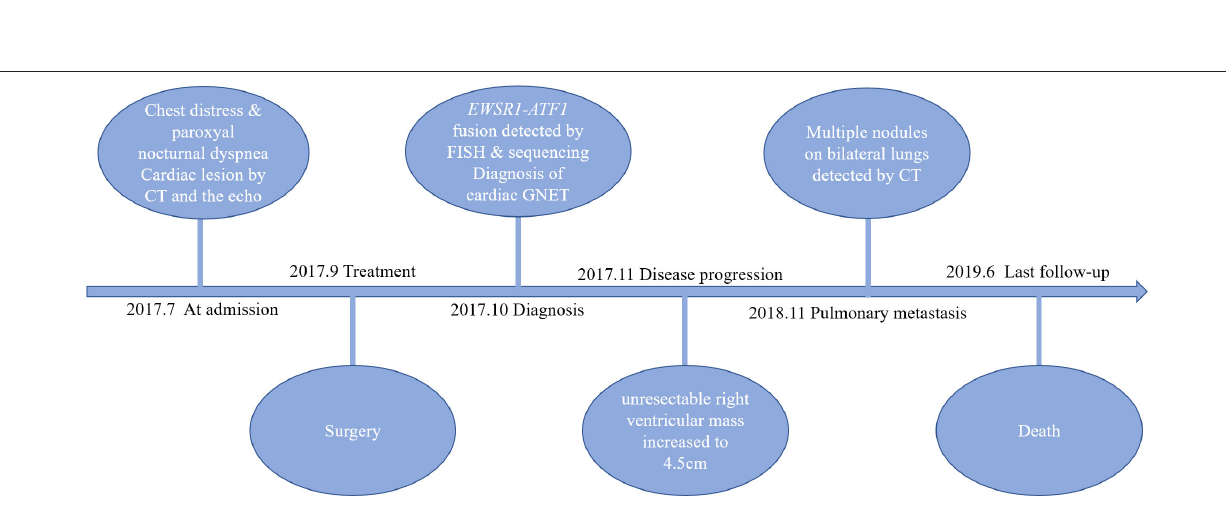
FIGURE 4 | Timeline of this